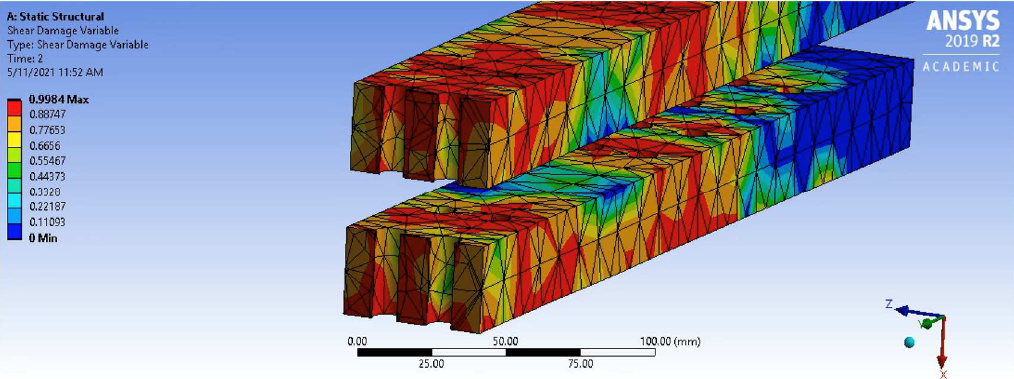
Figure 19. Shear Damage Status at Failure. Figure 20. Shear Damage Status at